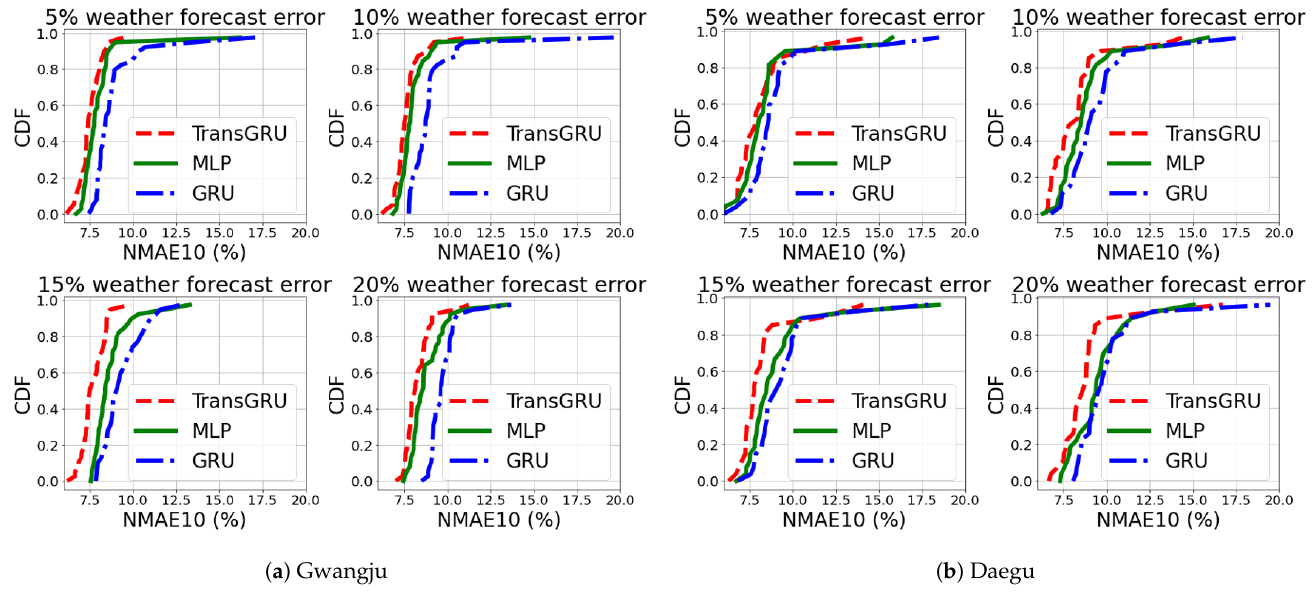
Figure 12. CDF comparison (individual PV sites